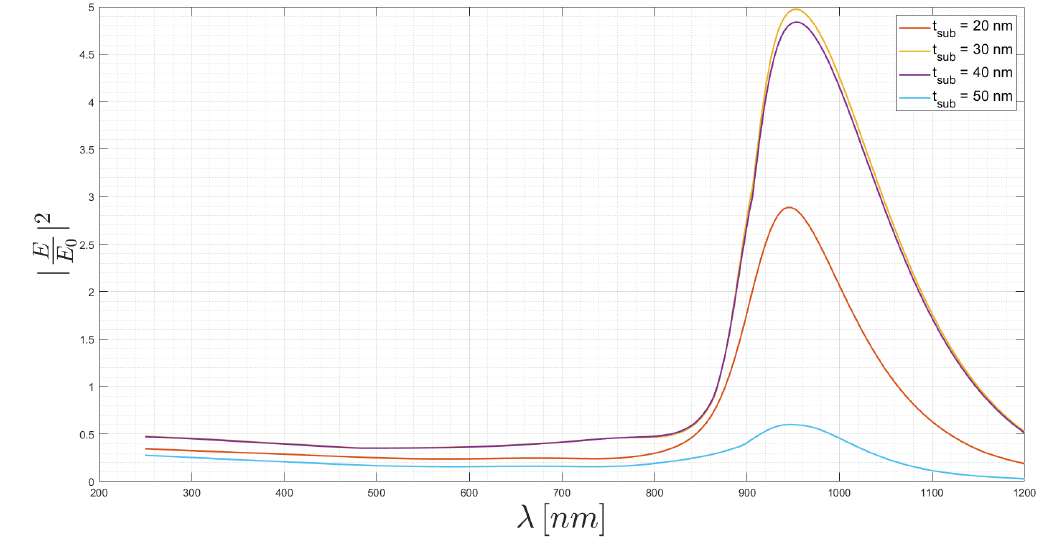
Figure 9. Substrate thickness sweep on a gold nanostructure with a quartz substrate.